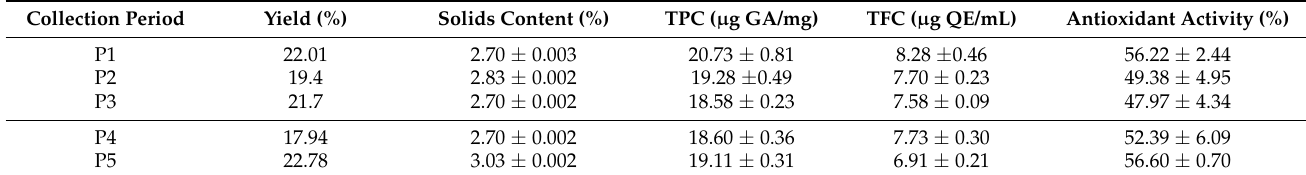
Table 3. Results from seasonal study of M. chamissois Naudin leaves.